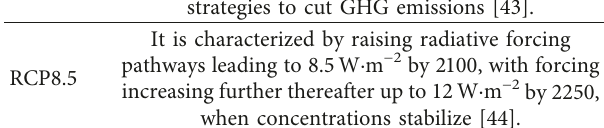
Table 2: Representative concentration pathways considered in this study.